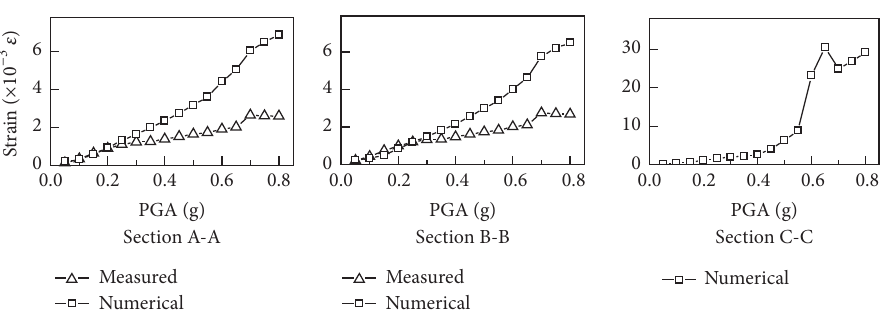
Figure 16: Measured and numerical results of maximum longitudinal steel strain response for the